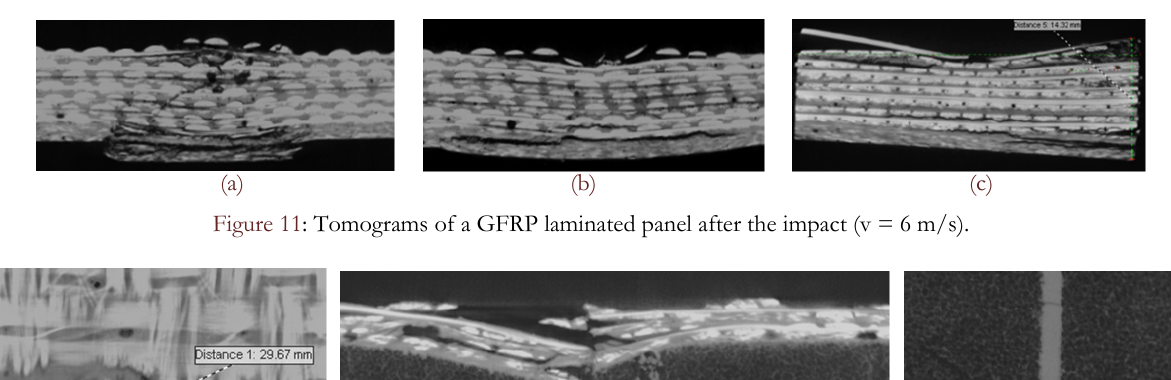
Figure 10: Tomograms of a GFRP laminated panel after the impact (v = 6 m/s).